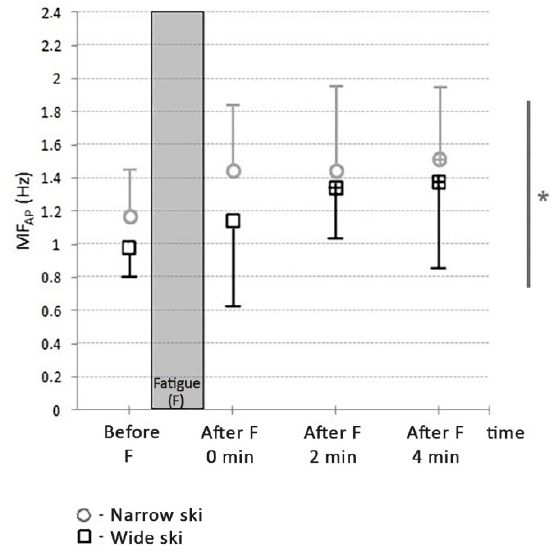
Figure 9. The mean frequency of the power spectrum of CoP in the anteroposterior direction (MF AP ) in a prefatigued state (before F) and at different times after fatiguing (after F) with two different ski waist-widths. + depicts statistically significant difference compared to prefatigued state ( p < 0.05); * depicts statistically significant difference between all-narrow against all-wide waist-width measurements.